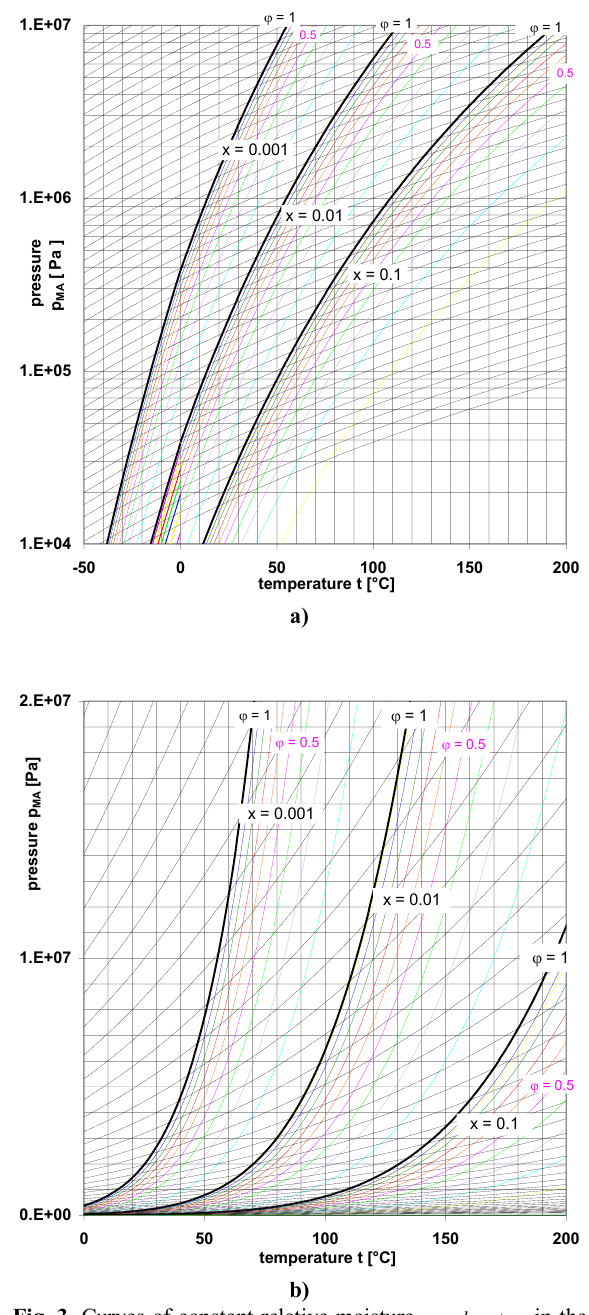
Fig. 3. Curves of constant relative moisture . konst  in the equilibrium p - t diagram for selected values of constant specific moisture   kg/kg x DAV